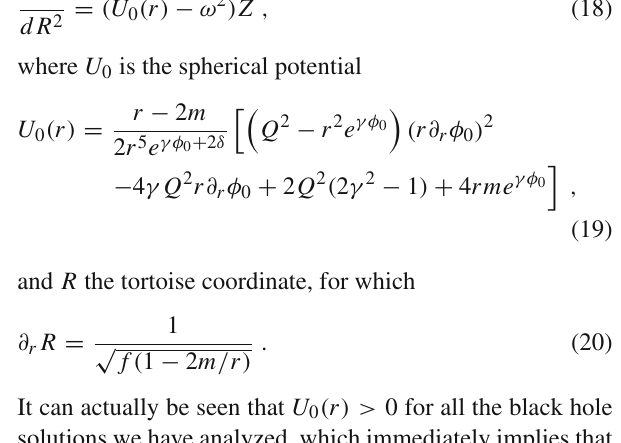
Fig. 1 Static spherically symmetric black hole solutions: (left) Dila- ton charge Q s versus the electric charge Q , both scaled by the mass M , for several values of the coupling constant γ ; in black for RN; in red,